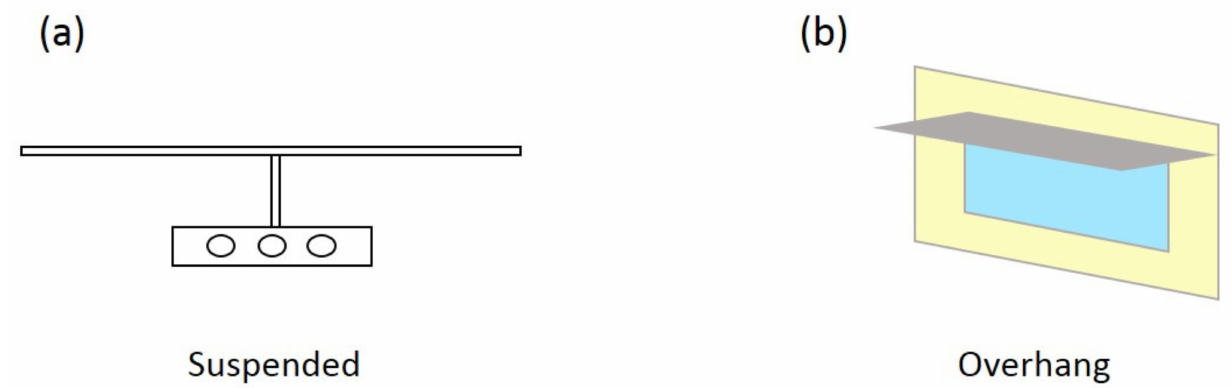
Figure 5. The type of lighting ( a ) and the type of external light-breakers ( b ) adopted in the DesignBuilder program for the hall in Słomniki